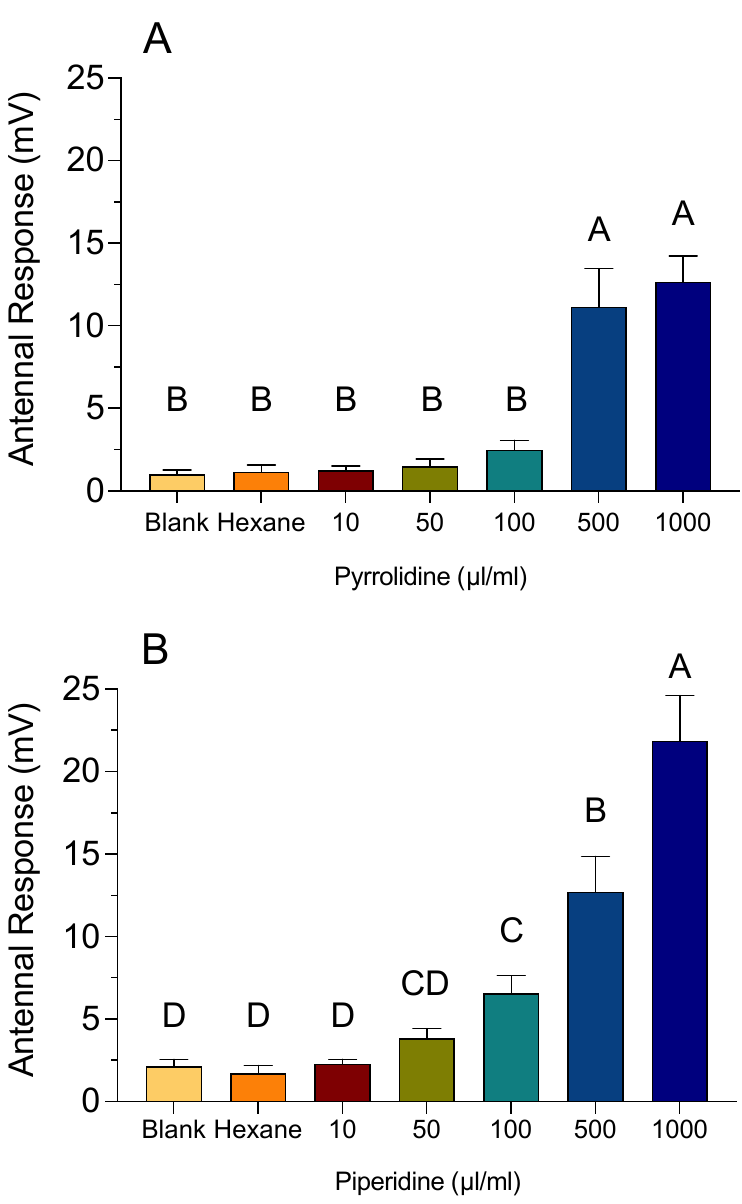
Figure 9. Electroantennogram (EAG) recordings of bee antennae exposed to the HCAs pyrrolidine ( A ) and piperidine ( B ). The change in voltage was calculated by subtracting the absolute value of the baseline voltage from the absolute value of the response voltage. An empty Pasteur pipette (blank) and hexane-treated filter paper served as a control and carrier solvent treatment, respectively. Vertical bars represent the mean ± standard error. Different letters above the bars indicate a significant difference between treatments using an ANOVA with Tukey’s multiple comparison test ( P < 0.05).